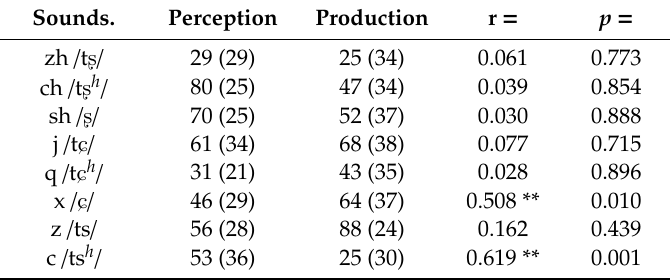
Table 7. Pearson coe ffi cients correlation tests between the % correct perception and production scores (** p < 0.01).